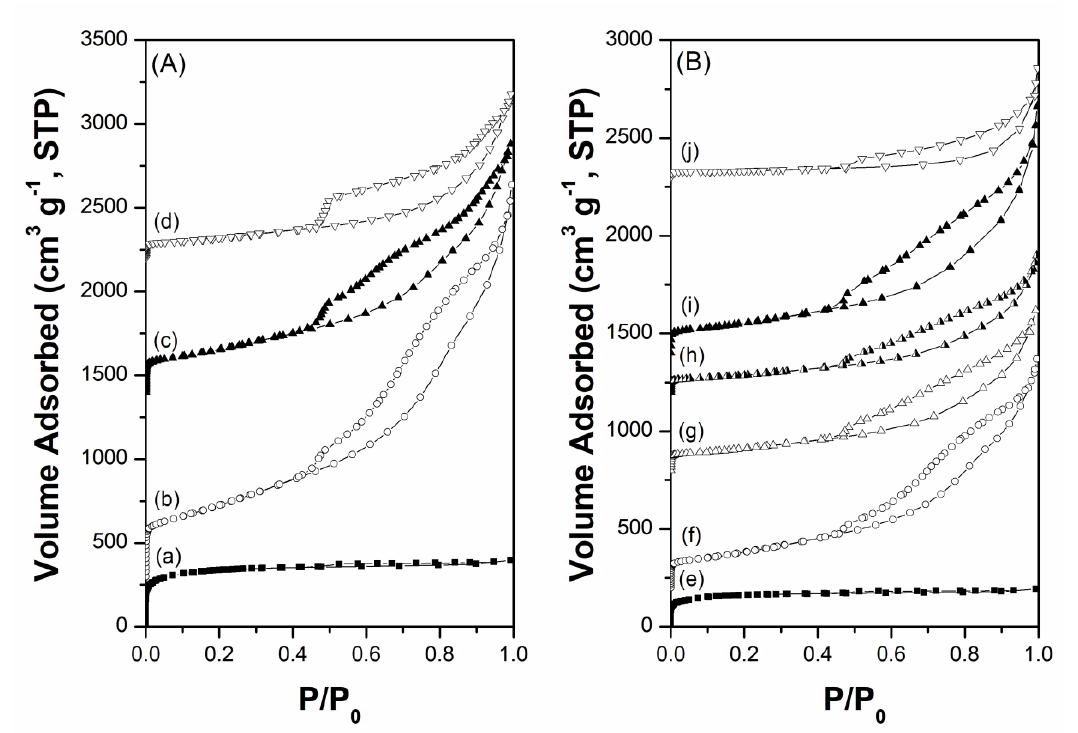
Figure 2. N 2 adsorption-desorption isotherms of ( A ) carbon materials—(a) AC, (b) MPC-15, (c) MPC-18 and (d) MPC-21 and ( B ) the prepared Cs-Ru catalysts—(e) 2.5Cs-10Ru / AC, (f) 2.5Cs-10Ru / MPC-15, (g) 10Cs-2.5Ru / MPC-18, (h) 5Cs-5Ru / MPC-18, (i) 2.5Cs-10Ru / MPC-18 and (j) 2.5Cs-10Ru /